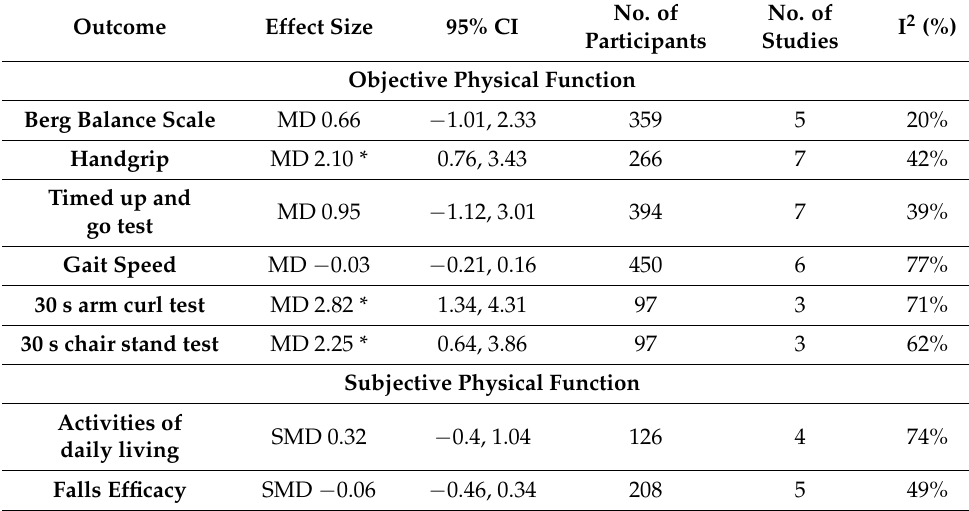
Table 3. Results from meta-analysis.